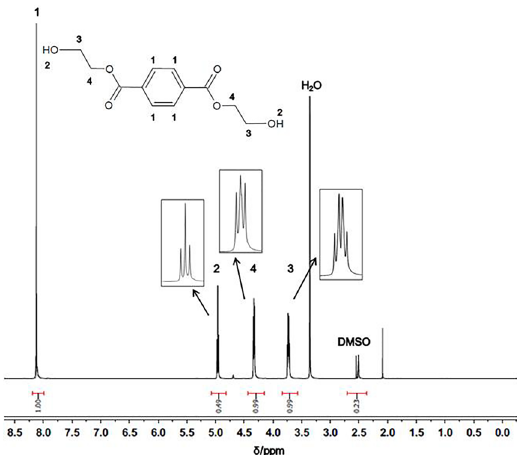
Figure 7. 1 H-NMR spectrum for BHET, the main product of PET glycolysis.